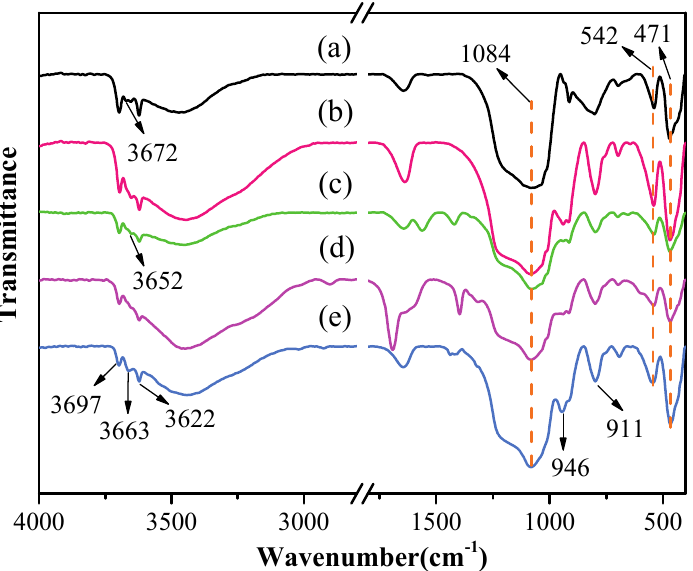
Figure 3. The FTIR spectra (400 − 4000 cm − 1 ) of ( a ) original kaolinite; ( b ) acidified kaolinite; ( c ) the KAc–kaolinite complex; ( d ) the FA–kaolinite complex and ( e ) the DMSO–kaolinite complex.